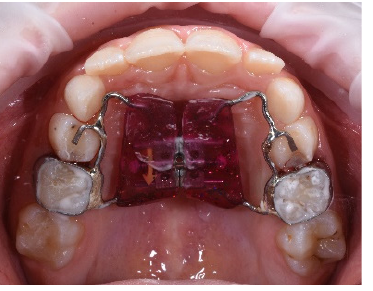
Figure 1. Conventional appliance RME: TTB RME and TB RME.